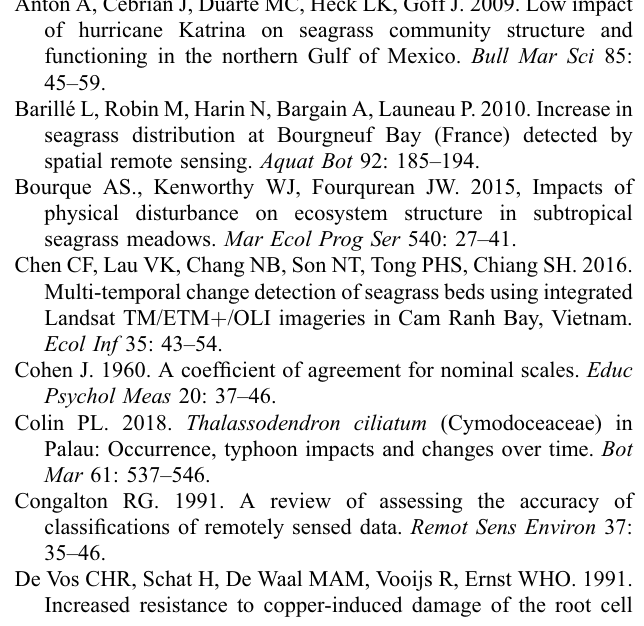
Table S2. Confusion matrix of the comparison between Landsat image classi fi cation result and ground reference data (validation data set) at TL in 2019.